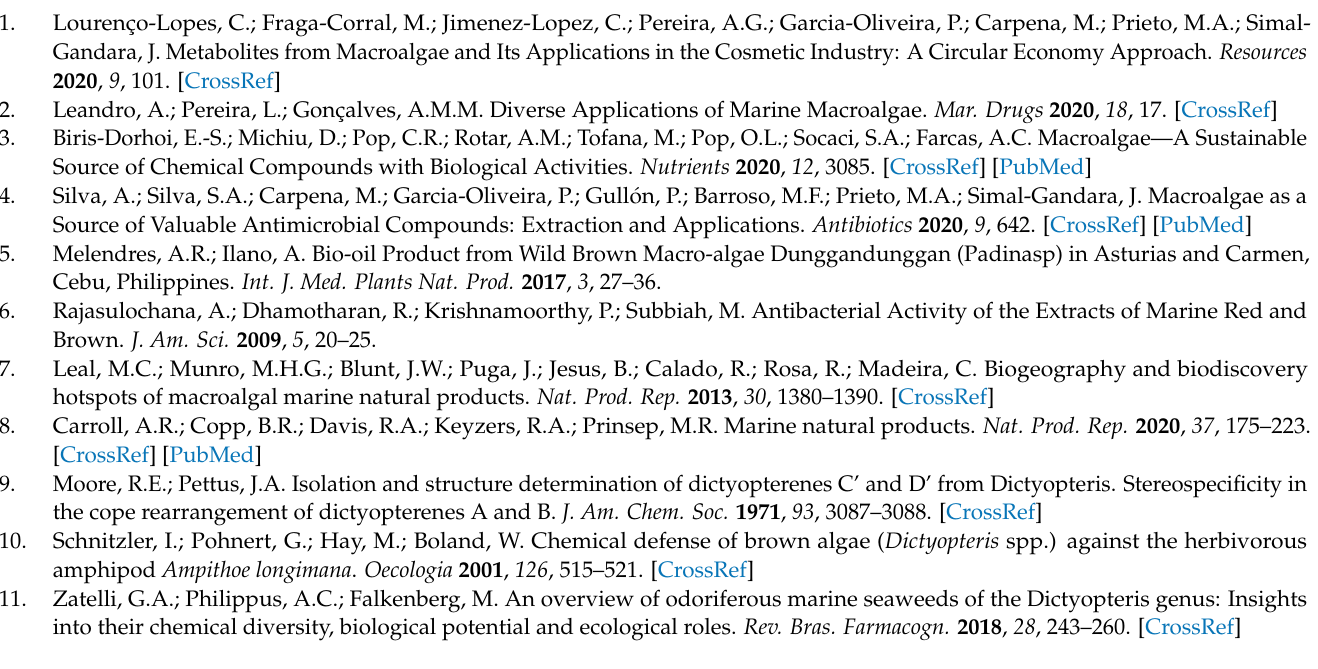
ESI-MS of the compounds 1 – 12 ; Figure S2: Superimposed view of co-crystalized ligand in 4IZW. The docked and the X-ray conformations of compound are shown in gray and green colors, respec- tively; Table S1: The predicted ADMET properties of